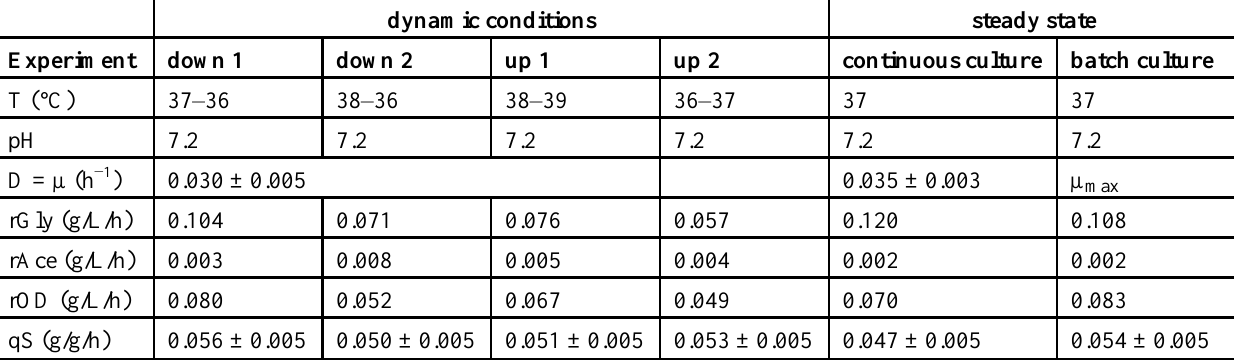
Table 1. Comparison of the different process modes for the verification of the dynamic experiments. The specific substrate uptake rates of dynamic ramps, steady state continuous conditions and batch results were compared with the same pH value, in the optimum temperature range and with comparabe dilution rates. In accordance with the three- dimensional ramp representations, for better overview, the volumetric rates are also included in each case. Investigating the specifc substrate uptake rates, ANOVA results revealed that no significant difference was obtained among the dynamic experiments and the steady state continuous